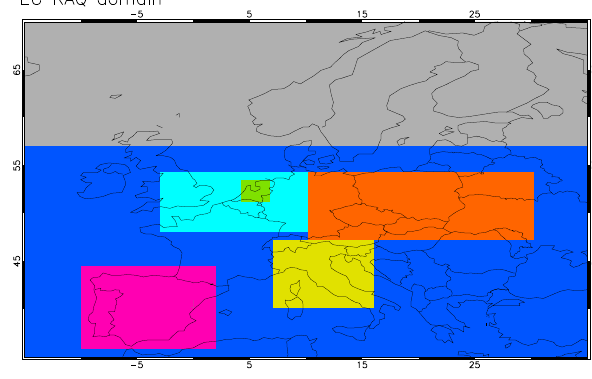
Fig. 2. Illustration of regions as defined in Table